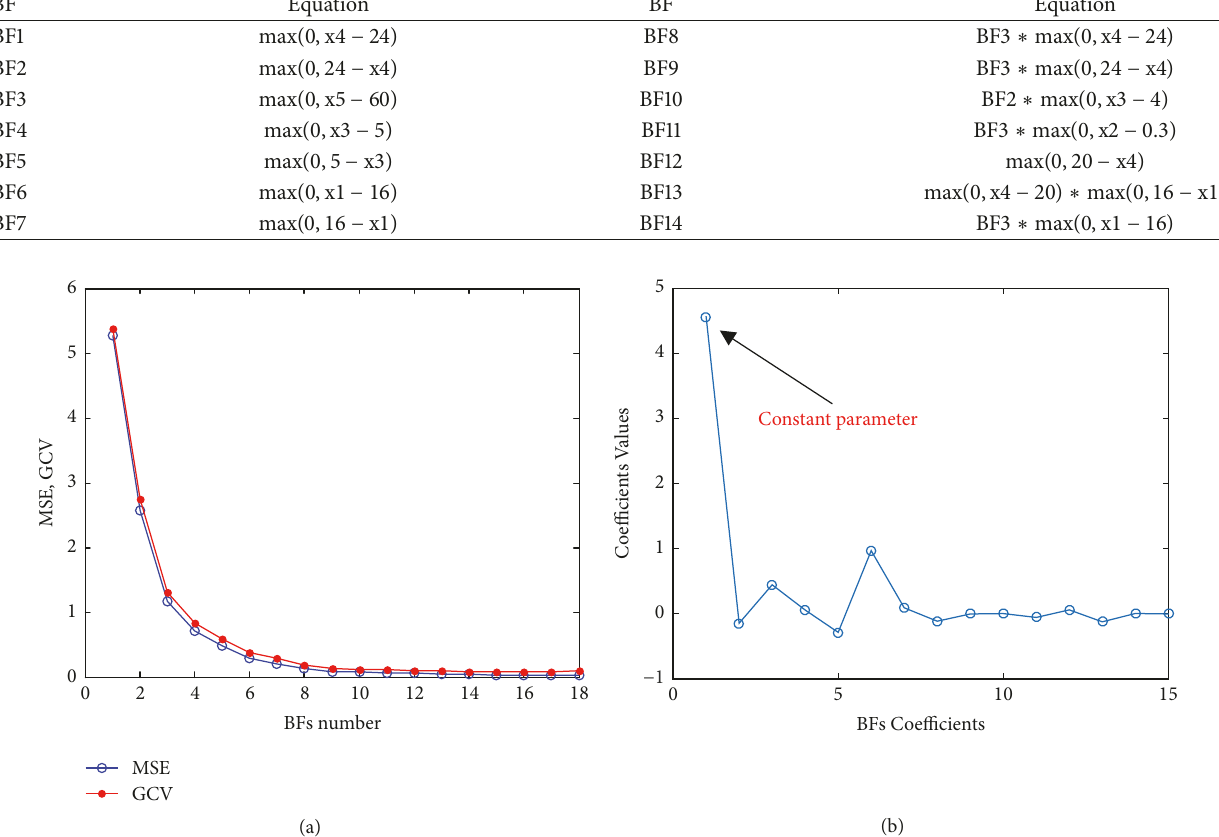
Figure 5: BFs number and coefficient for the settlement prediction: (a) BFs numbers, (b) BFs coefficients.